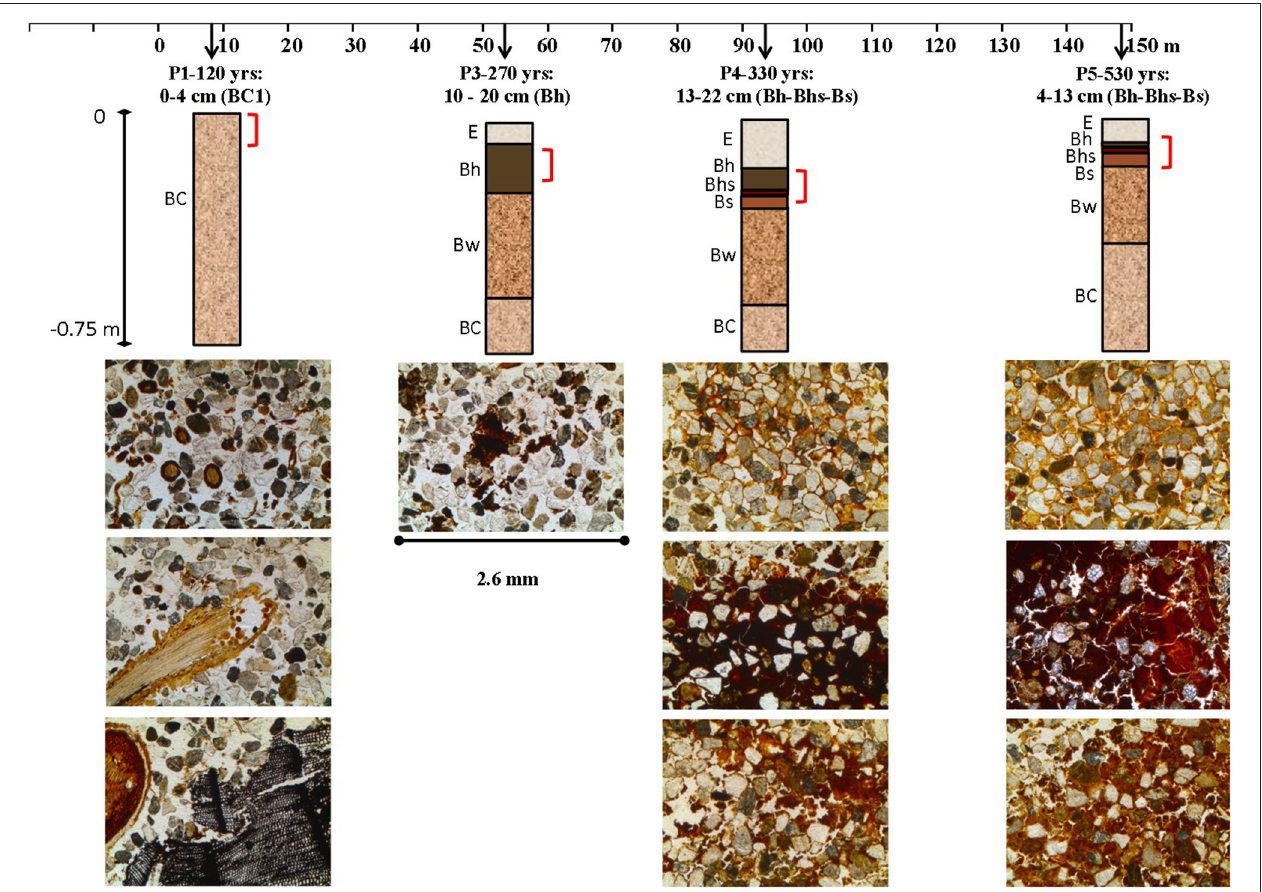
FIGURE 3 | Micromorphological observations from thin sections of kubiëna boxes taken in the P1–120 years BC1 horizon, P3–270 years Bh horizon, and P4–330 and P5–530 years Bh, Bhs and Bs